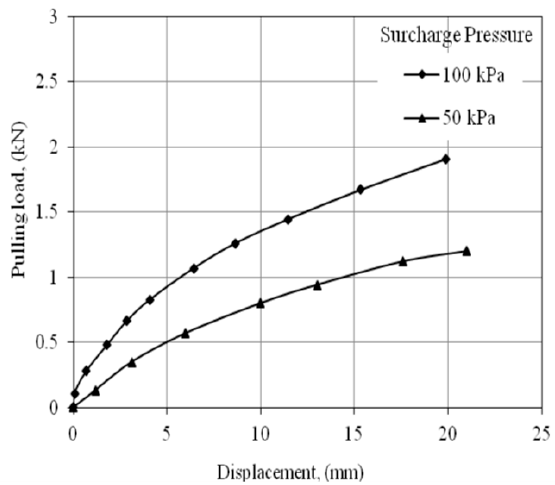
Figure 1. Relationship between the pullout load and displacement in geogrid at different confining stresses (Mabrouk [16]).